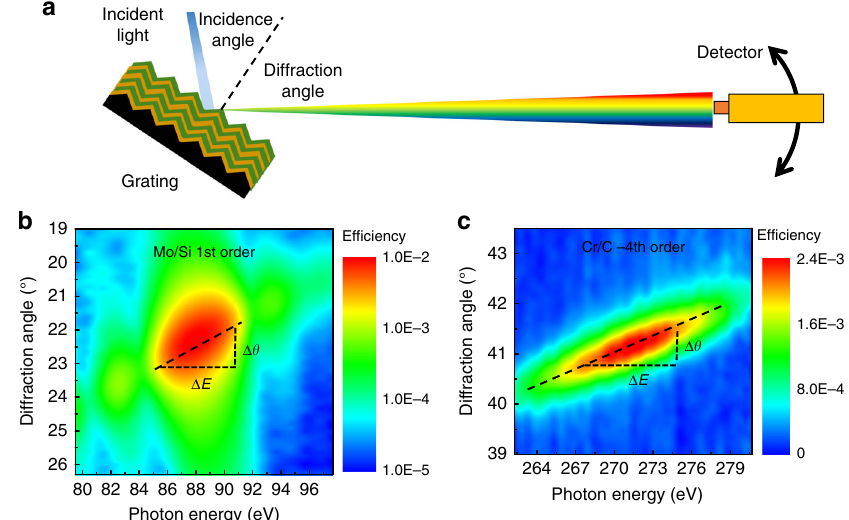
Fig. 4 Estimation of the angular dispersion of the fabricated MBGs. a Schematic of the diffraction geometry of the gratings. b , c Two-dimensional diffraction measurements as a function of diffraction angle and photon energy of the + 1st order of the Mo/Si MBG at an incident angle of 5° and the − 4th order of the Cr/C MBG at an incident angle of 75°,